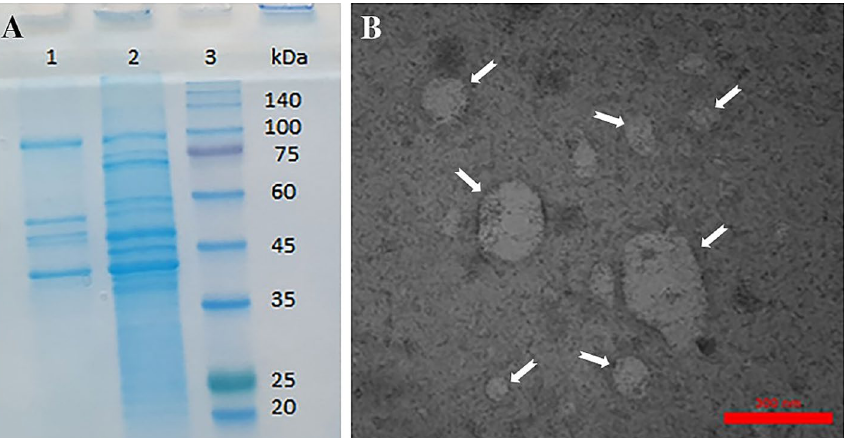
Figure 1. A.muciniphila OMVs confirmation. ( A ) SDS-PAGE. (1) OMVs proteins (2) supernatant (3) molecular weight Protein Marker ( B ) TEM image × 18,000. Arrows indicate OMVs in different sizes (30– 300